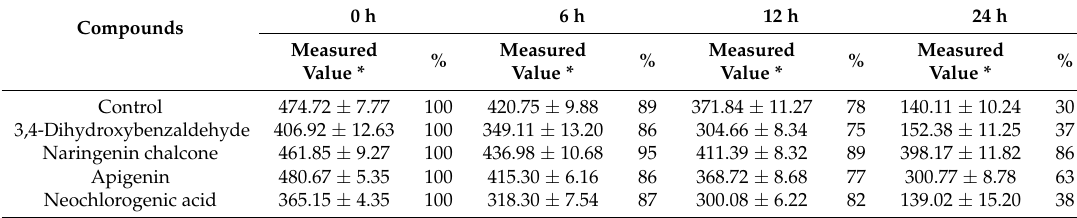
* The average of the five measurements.